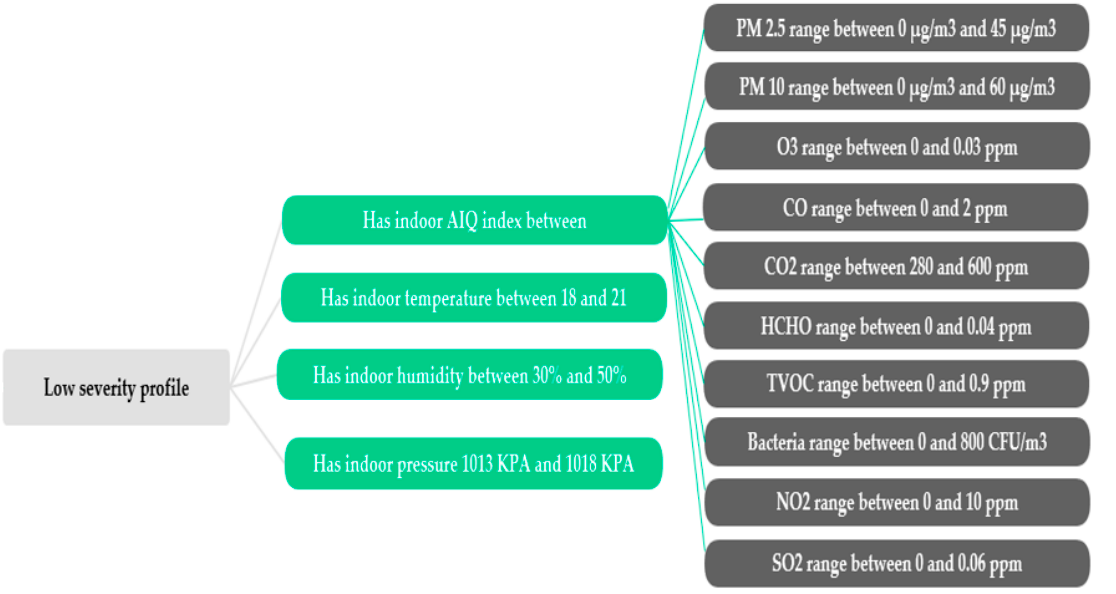
Figure 4. An example of indoor rules with low severity profile.